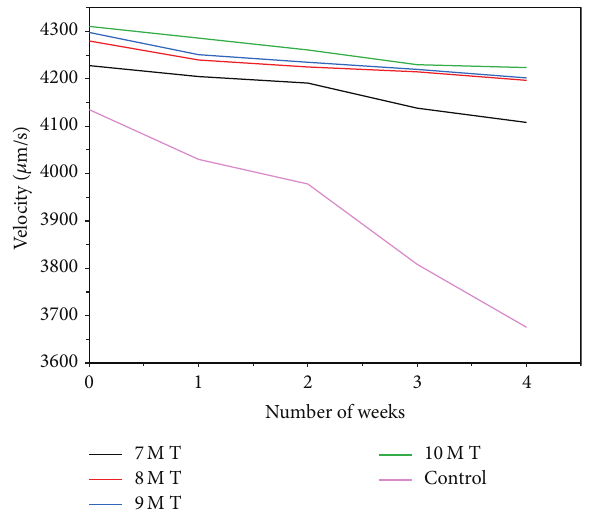
Figure 15: UPV for sulfuric acid.